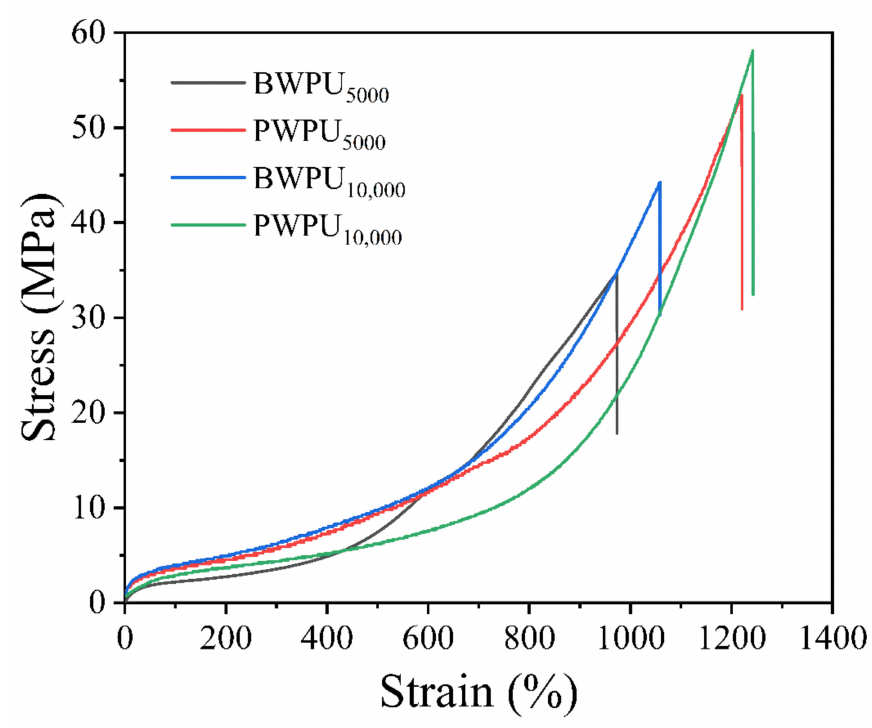
Figure 4. Stress-strain curves of BWPU 5000 , BWPU 10,000 , PWPU 5000 and PWPU 10,000